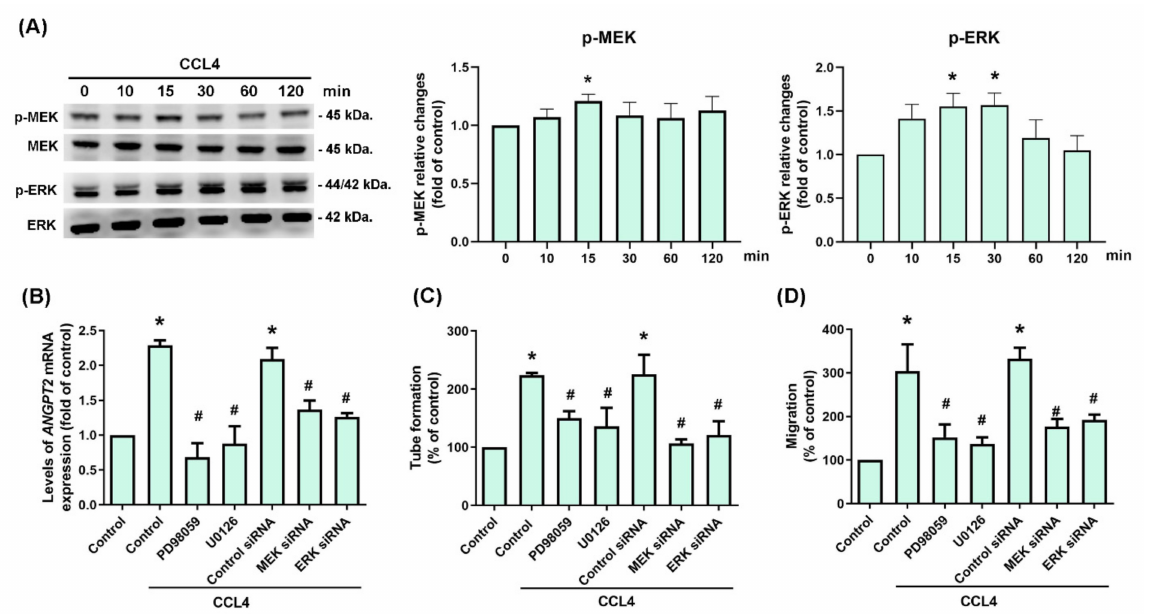
Figure 4. CCL4 promotes Angpt2 expression and angiogenesis by activating MEK and ERK signaling. ( A ) SCC4 cells were incubated with CCL4 (30 µ g/mL) for the indicated time intervals, then MEK and ERK activation was examined by Western blot. ( B ) SCC4 cells were treated with a MEK inhibitor (PD98059, 10 µ M) or ERK inhibitor (U0126, 10 µ M) for 30 min, or transfected with MEK or